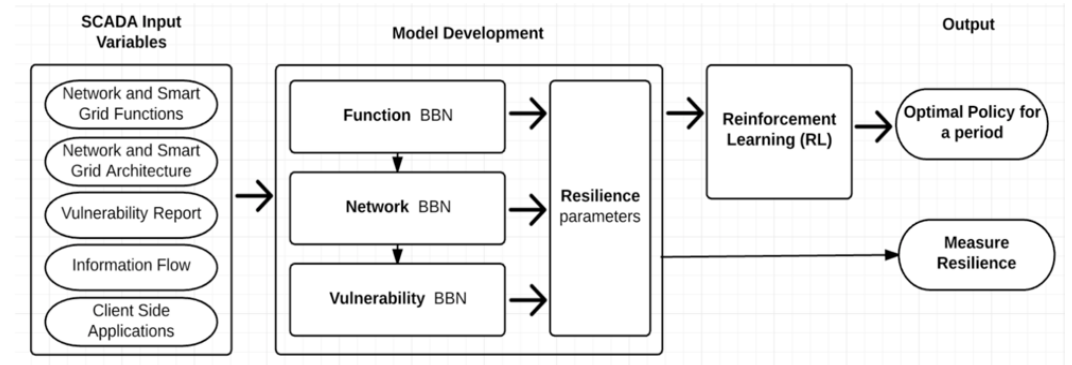
Figure 5. Bayesian Attack Graph for Smart Grid tool design. BBN, Bayesian Belief Network. Electronics 2018 , 7 , x FOR PEER REVIEW